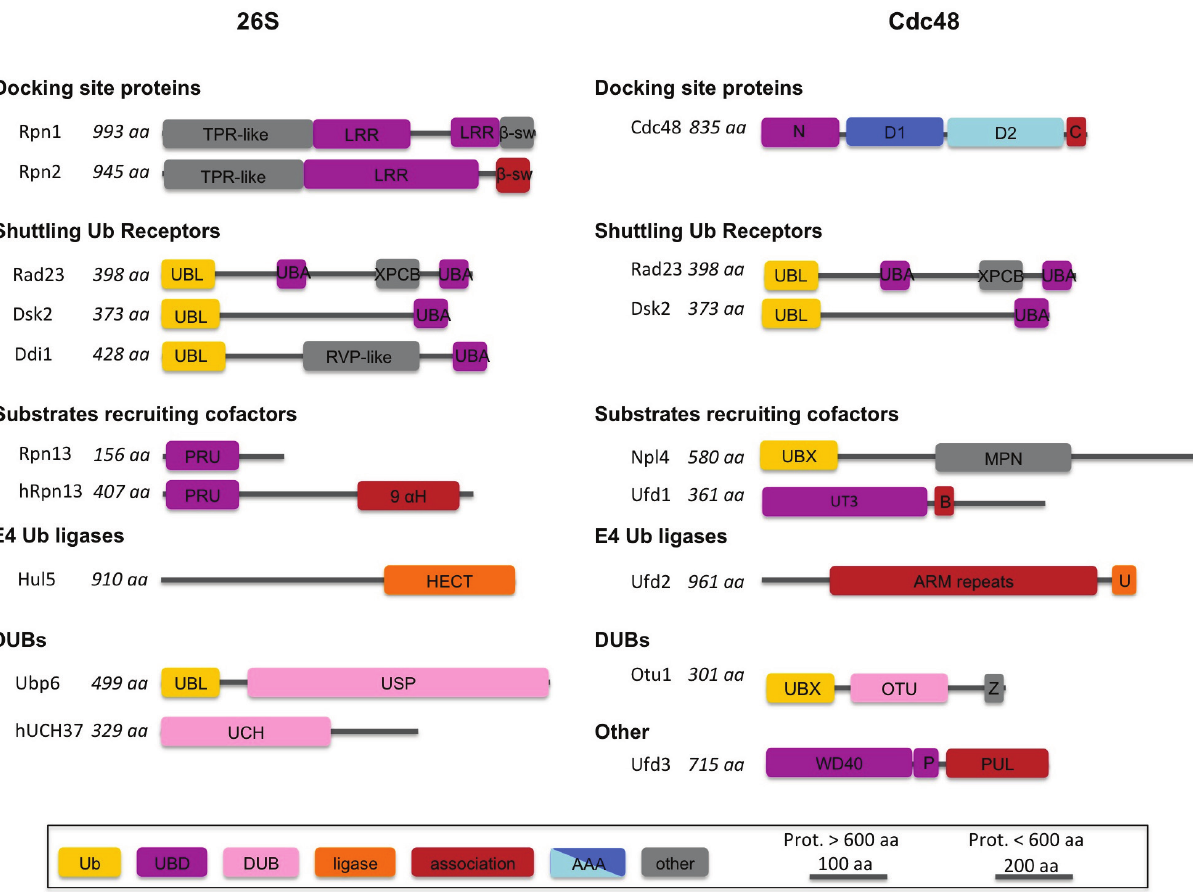
Figure 3. Schematic representation of sequences of PIPs and the major Cdc48-associated cofactors involved in the UPS. PIPs bind to the docking platforms, Rpn1 and Rpn2, all Cdc48-associated proteins to either the Cdc48 N-domain or the C-terminal tail (C). Yellow: domains with an Ub-related fold; purple: domains that bind to Ub and Ub-related domains (UBD); pink: DUB domains; orange: ubiquitin ligase domains; red: domains involved in PIP or Cdc48-cofactor association; blue: AAA-domain; gray: established domains with different or unknown functions. The following additional abbreviations are introduced: TPR: tetratricopeptide repeat; (cid:3)-sw: (cid:3)-sandwich domain; 9(cid:2)H: alpha helical bundle; RVP: retroviral protease-like domain; XPCB: xeroderma pigmentosum group C protein-like domain; USP: ubiquitin-specific protease domain; B: BS1; ARM: armadillo-repeat containing domain; U: RING-like U-box domain; Z: Zn-finger motif; WD40: WD40-repeat containing domain; P: PLAA family ubiquitin binding (PFU)